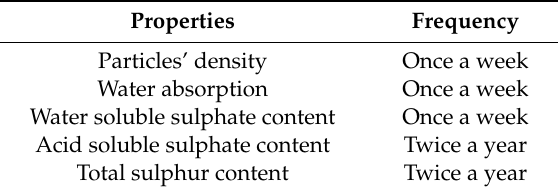
Table 7. Minimum composition determination frequencies.